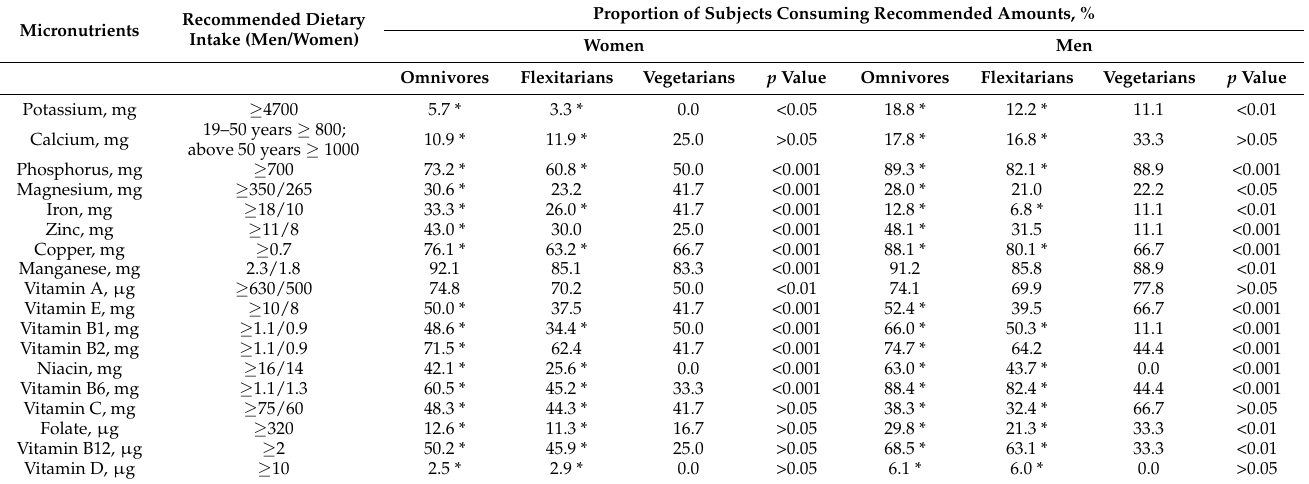
Table 5. Proportion of subjects consuming recommended amounts of micronutrients, including antioxidants, by diet